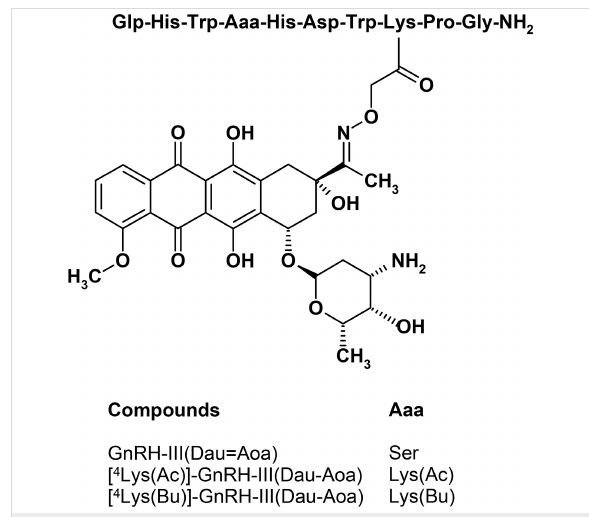
Figure 1: Schematic structure of Dau-conjugated GnRH-III or its deriv- atives containing 4 Lys with acetyl or butyryl (Bu) side